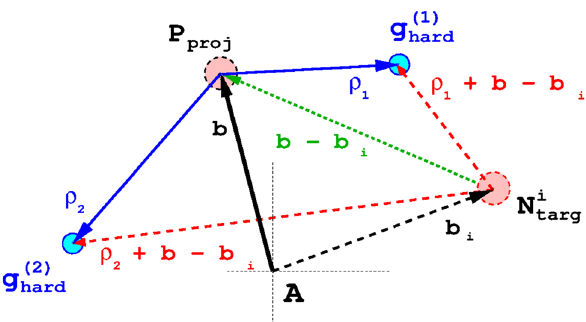
Fig. 4 Sketch of the transverse geometry of the the double parton col- lisions. The incoming proton, P proj , is displaced in transverse space by the vector b from the nucleus center, while the i -th nucleon in the tar- get, N i target , is displaced in transverse space by the vector b i from the nucleus center. In this work, the hard interaction points g by ρ 1 and ρ 2 from P proj , are integrated over the whole transverse plane, event-by-event. The remaining vector notations are self-explanatory